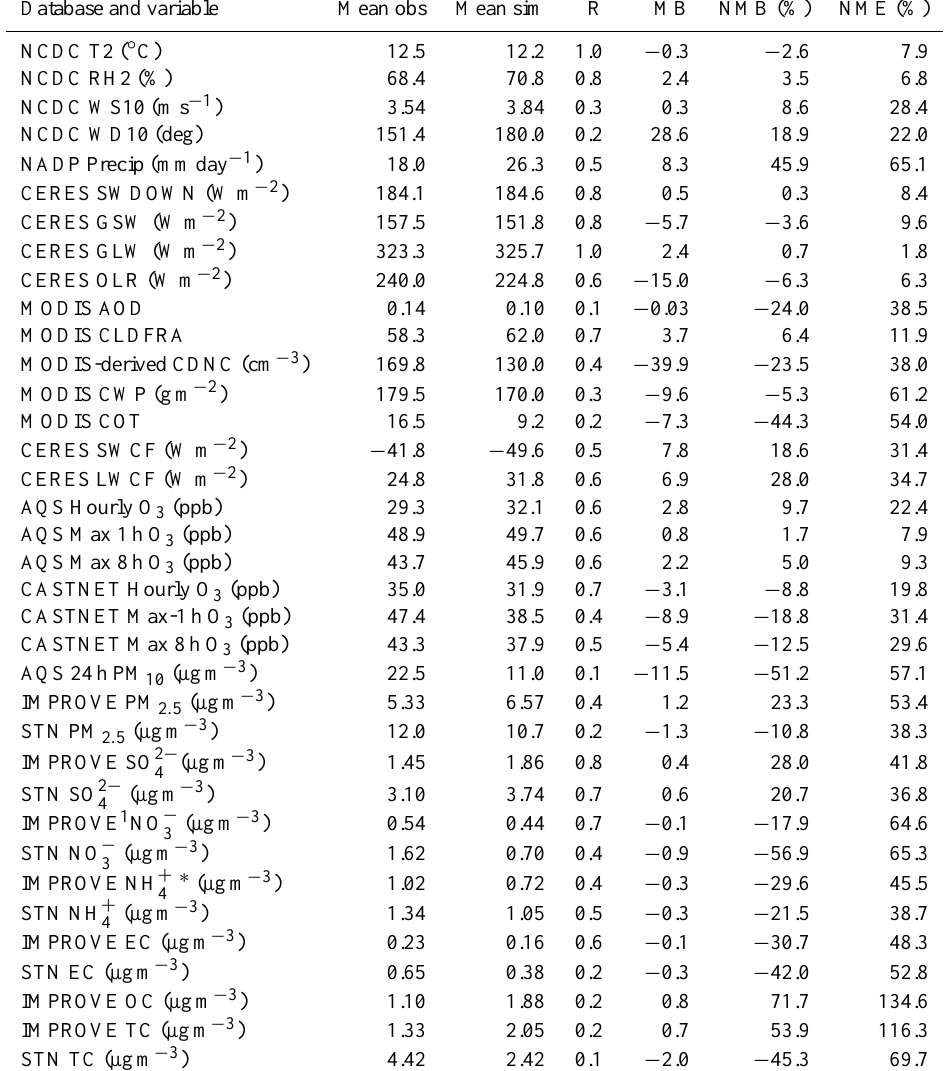
Table 2. The 10-year (2001–2010) average performance statistics for the simulated meteorological, aerosol, cloud, radiation variables, and chemical species against surface observational networks and satellite retrieval